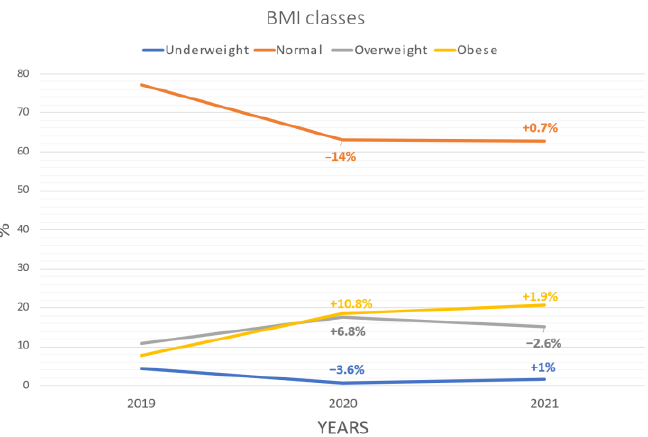
Figure 1. Changes in BMI classes percentages between 2019, 2020 and 2021.